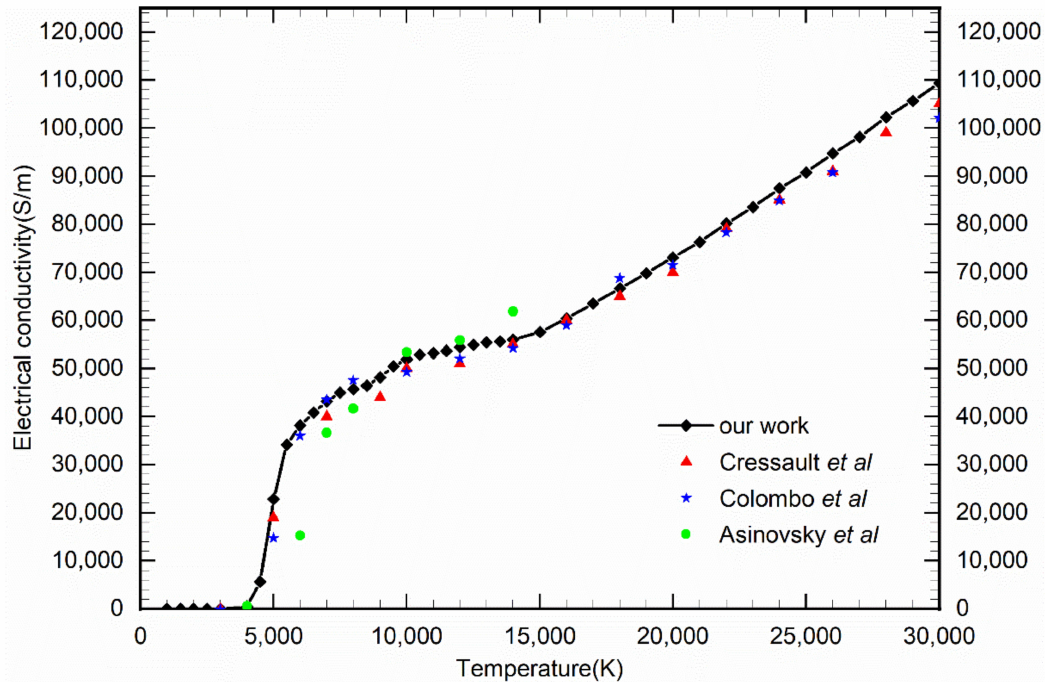
Figure 12. The electrical conductivity of pure CO 2 at 0.1 MPa. The calculated results are shown for